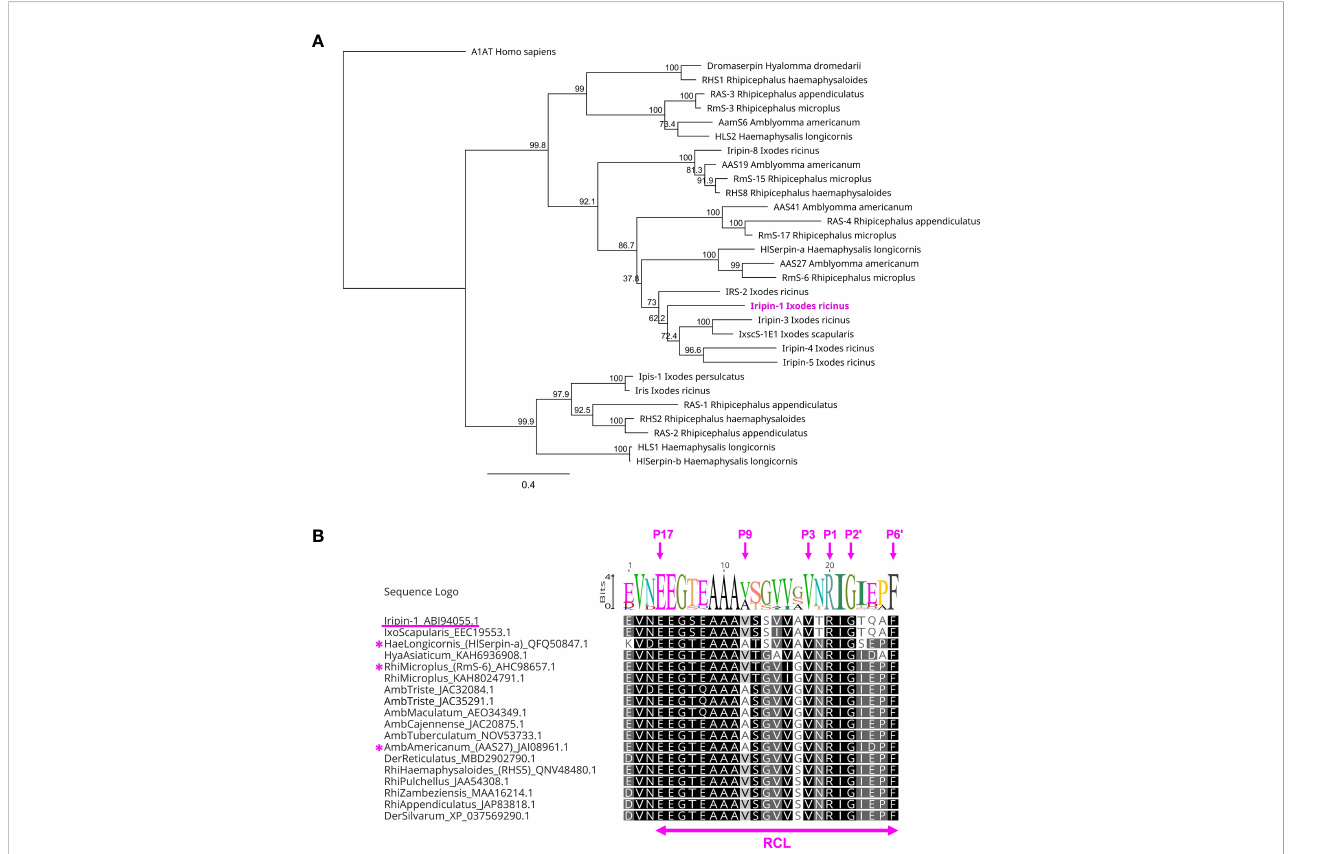
FIGURE 3 The phylogenetic relationship of Iripin-1 with other tick serpins. (A) The phylogenetic tree was built based on the protein sequences of functionally characterized tick serpins using the program PhyML and WAG substitution model. The human serpin a -1-antitrypsin (A1AT) was utilized as an outgroup to root the tree. The length of tree branches represents the number of substitutions per site. The reliability of each clade is expressed by a bootstrap value that was calculated based on 1,000 replicates. (B) Alignment of RCL regions of selected tick serpins. The amino acid sequences of serpins with Iripin-1-like RCL were retrieved from GenBank, and their RCLs were aligned using the aligner MUSCLE. The tick species and the GenBank accession number are written next to each sequence. The amino acid residues labeled with magenta arrows are numbered based on the standard nomenclature developed by Schechter and Berger (35). The serpins HlSerpin-a, RmS-6, and AAS27 are marked with a magenta